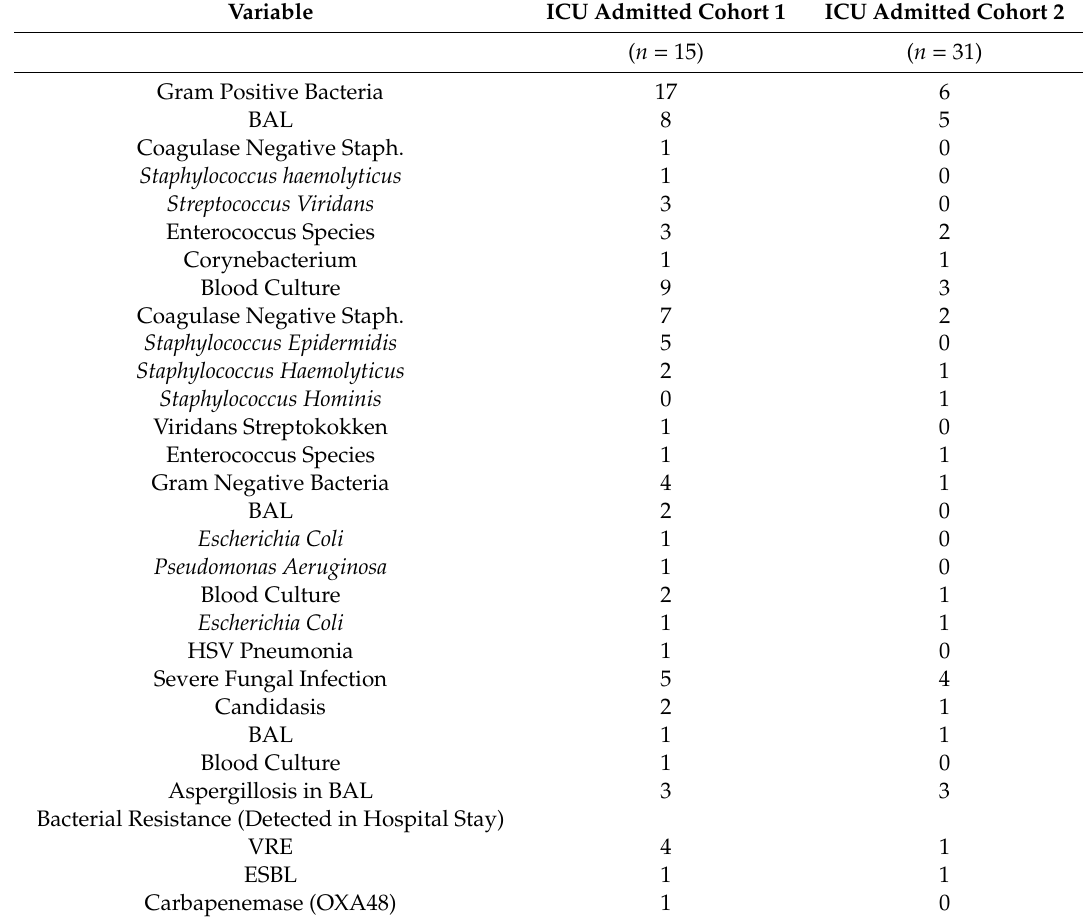
Table 5. Microbiological analysis of infections in patients admitted to the ICU. Cohort 1: patients admitted to the ICU due to immediate complications during HDT and ASCT treatment. Cohort 2 patient admitted within 6 months after high dose chemotherapy and ASCT (excluding cohort 1 patients) VRE: vancomycin resistant enterococcus; ESBL: extended spectrum β -lactamase producing bacteria. BAL: bronchoalveolar lavage Variable ICU Admitted Cohort